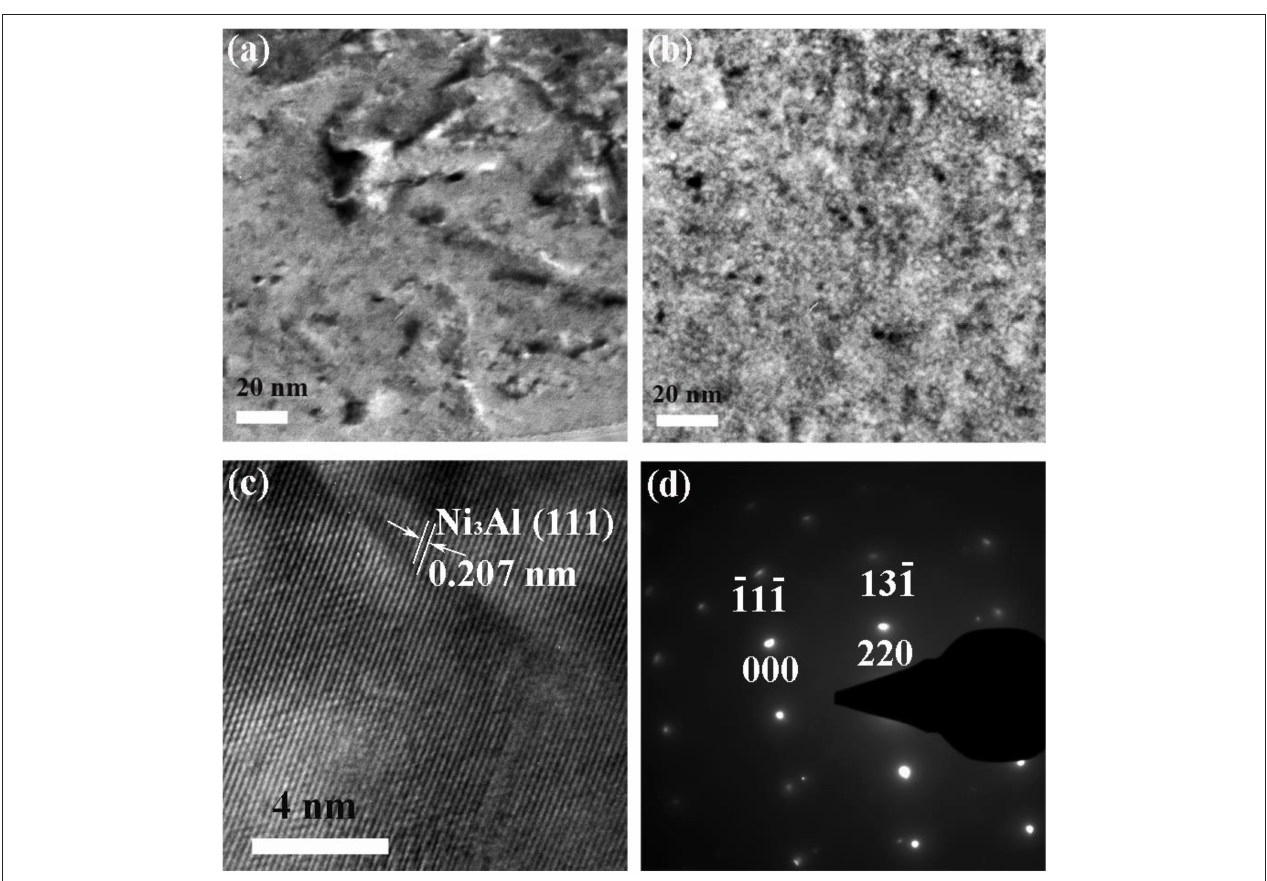
FIGURE 4 | TEM morphologies and corresponding SAED patterns of NiCrAlY coating: (a) as-sprayed, (b–d) 1,100 ◦ C heat treatment.